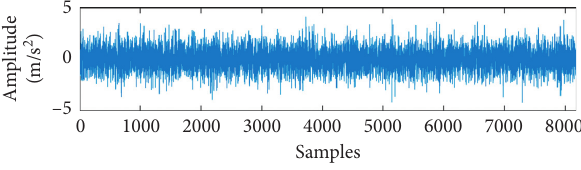
0 Figure 4: The angular signal with noise.